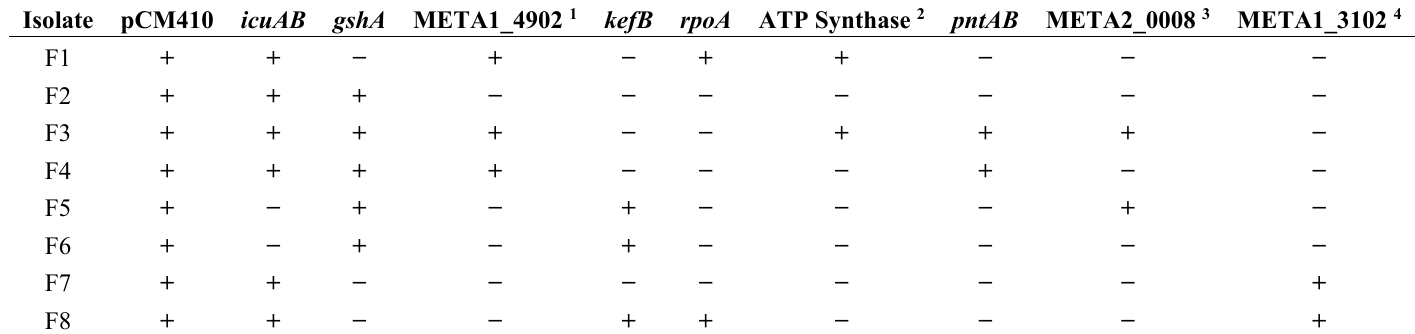
Table 2. Parallel evolution at specific genomic